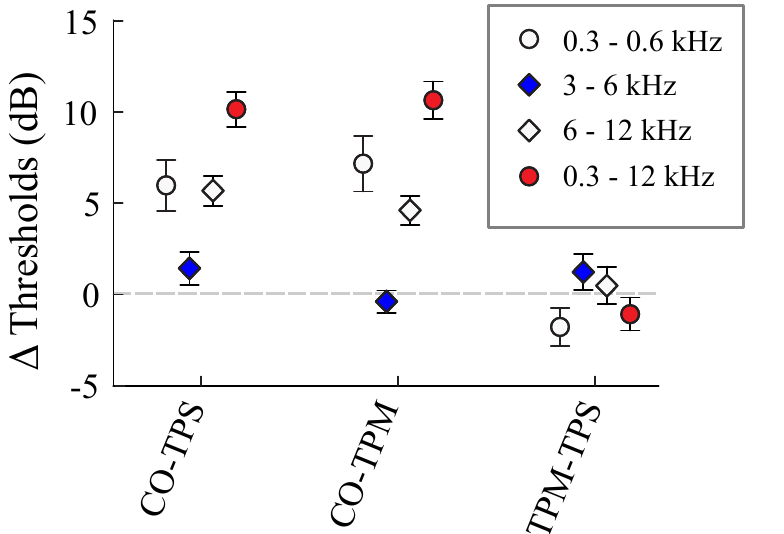
Figure 6. Mean spatial release from masking (SRM), CO − TPS and CO − TPM, and the difference in SRM between the TPS and TPM conditions (TPM − TPS) for 10 listeners. Error bars show the variability between listeners, in terms of the standard error of the